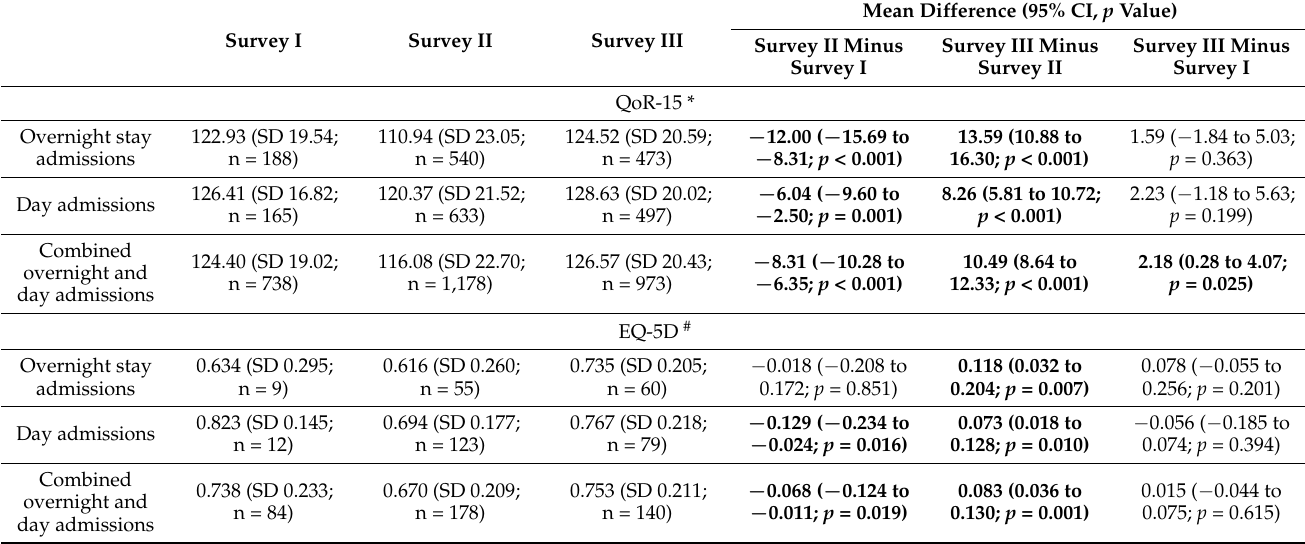
Table 2. QoR-15 and EQ-5D scores.